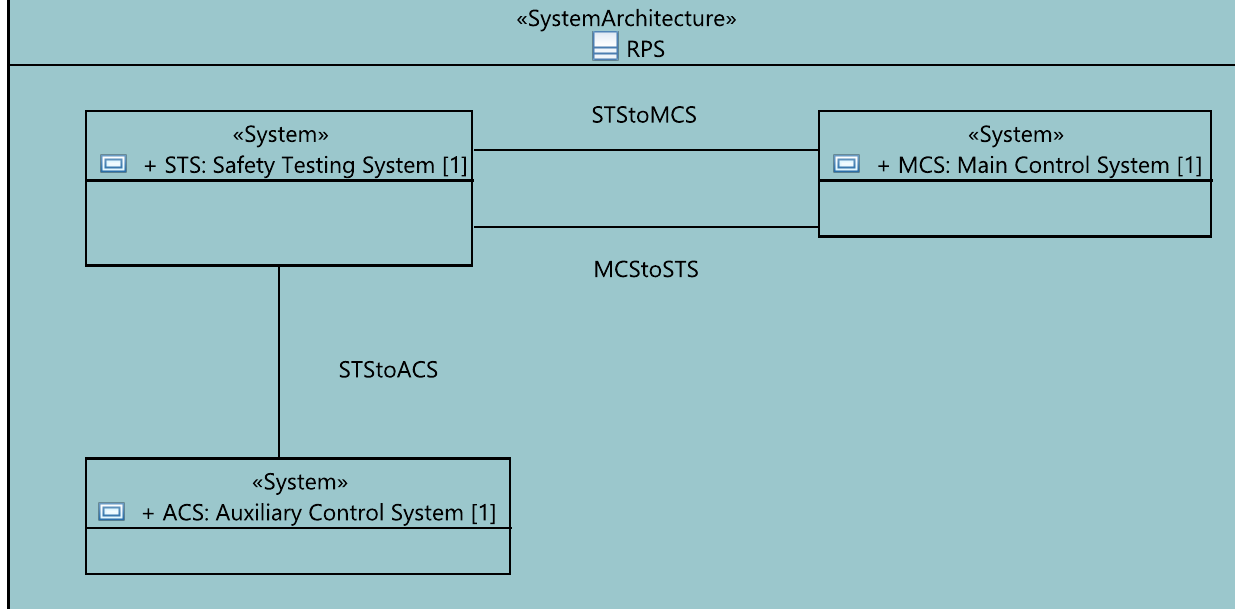
Figure 17. Communications between the RPS’